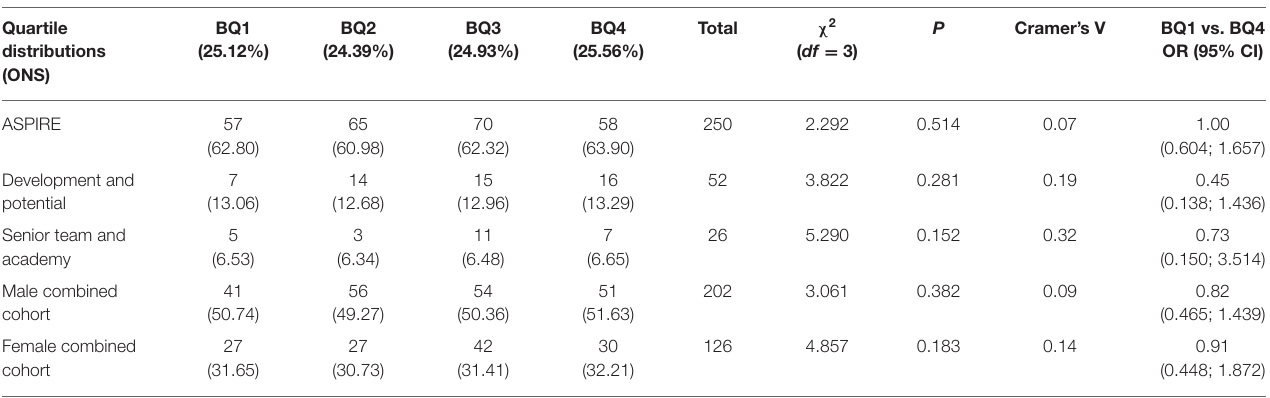
TABLE 1 | The distributions of BQs with chi-square, Cramer’s V, and OR analysis. Quartile